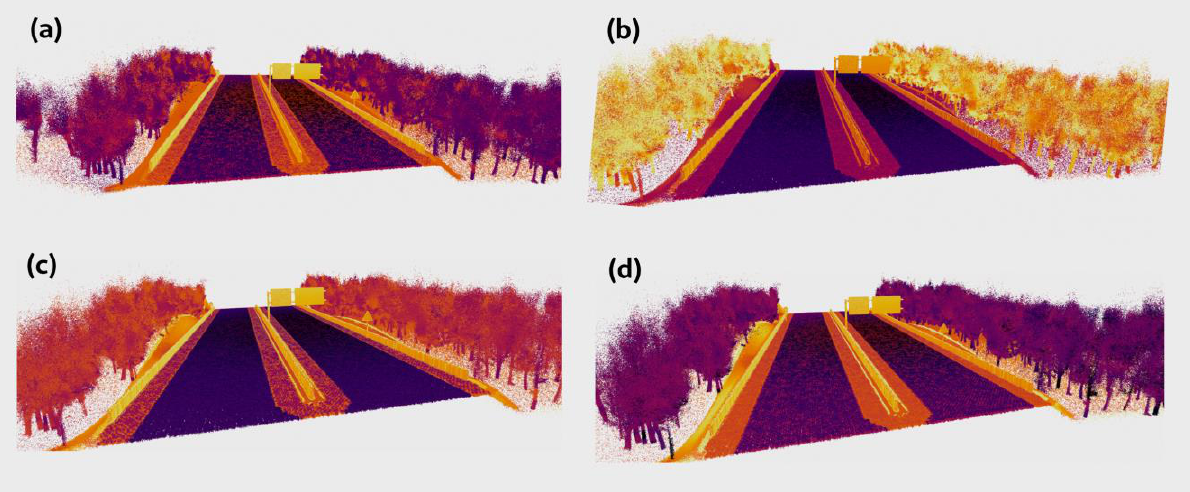
Figure 7. Pr/C views of the same highway point cloud at different spectral ranges: (a) 500 nm, (b) 900 nm, (c) 1400 nm and (d) 1928